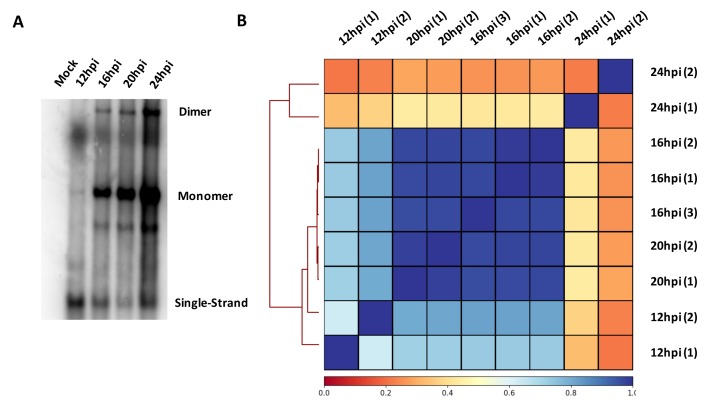
MVM replication during viral infection and correlation of V3C-seq interaction sites.(A) MVM replication over the timecourse of viral infection in parasynchronized murine A9 cells. A9 cells were infected at an MOI of 5. Cells were harvested at the indicated timepoints and Southern blot was performed as described in Materials and methods. DNA content was measured by nanodrop and equal amount of DNA was loaded in each well. The blot was hybridized with radiolabeled MVM probe and single stranded DNA, and replicative intermediates monomer and dimer forms are indicated on the right. (B) MVM interaction sites on the mouse genome across independent replicates at different timepoints were compared pairwise, and presented in the form of a clustered heatmap of Spearman correlation coefficients on the Galaxy server (Afgan et al., 2016; Ramírez et al., 2016). The timepoints and experimental replicate are indicated on the X and Y axes. Blue squares designate high correlation and red squares designate low correlation, and the spectrum of colors to correlation is shown below the heatmap.